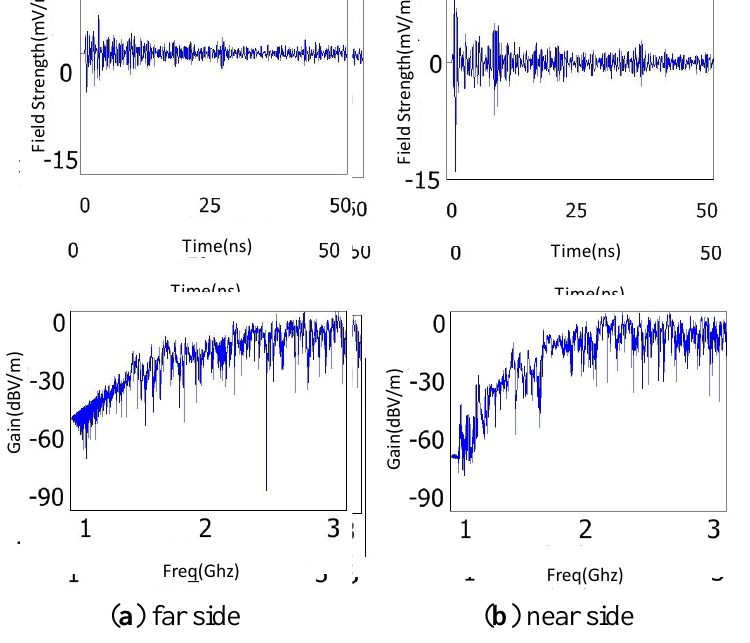
Figure 14. Simulation results of the influence of bus-bar on the propagation of EM waves.